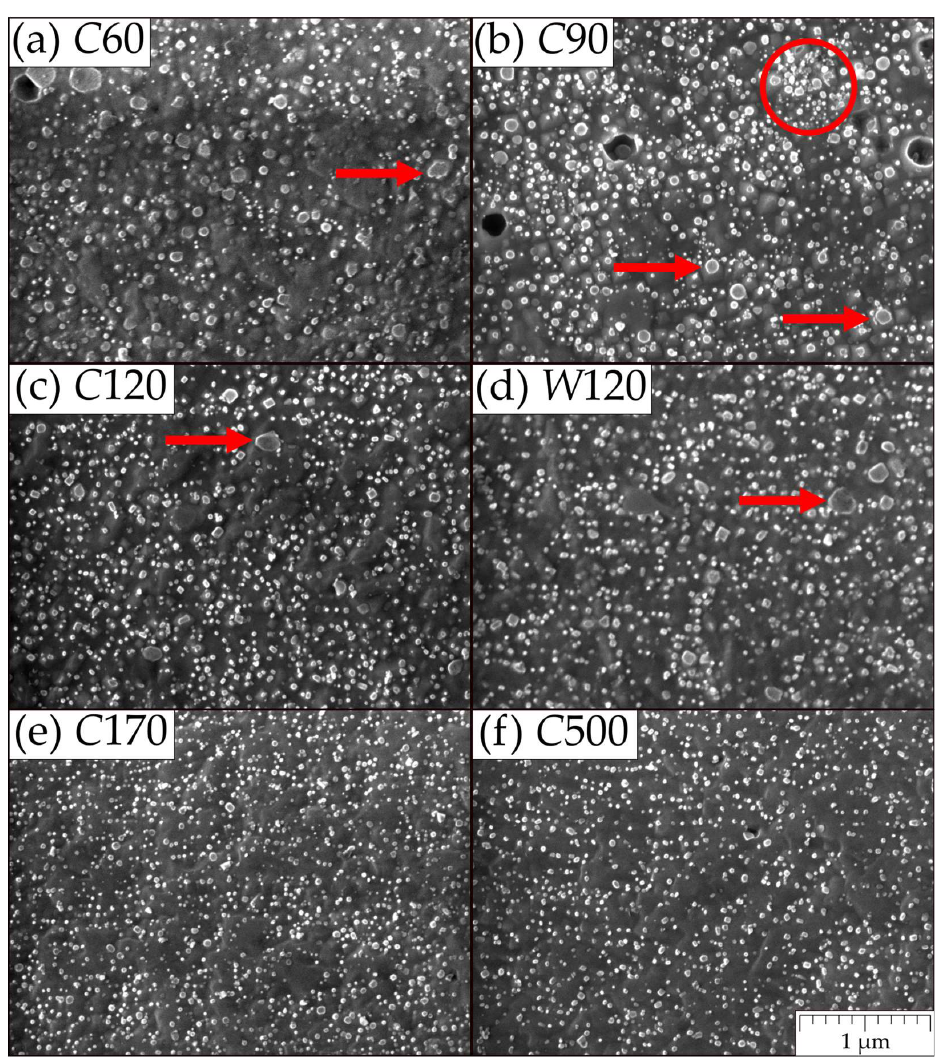
Figure 9. Representative morphologies of the nanooxide dispersoid of ( a ) C 60, ( b ) C 90, ( c ) C 120, ( d ) W 120, ( e ) C 170, and ( f ) C 500. Red arrows point out larger oxide particles and the red circle in ( b ) shows unfavorable clustering of smaller oxides.